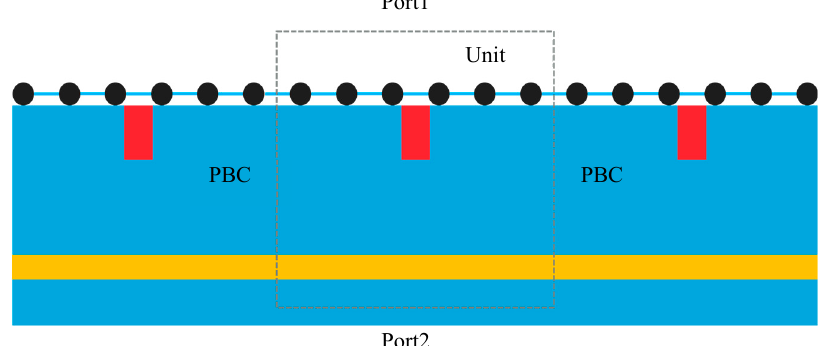
Figure 2. Simulation settings, showing the unit-cell and its boundary conditions.